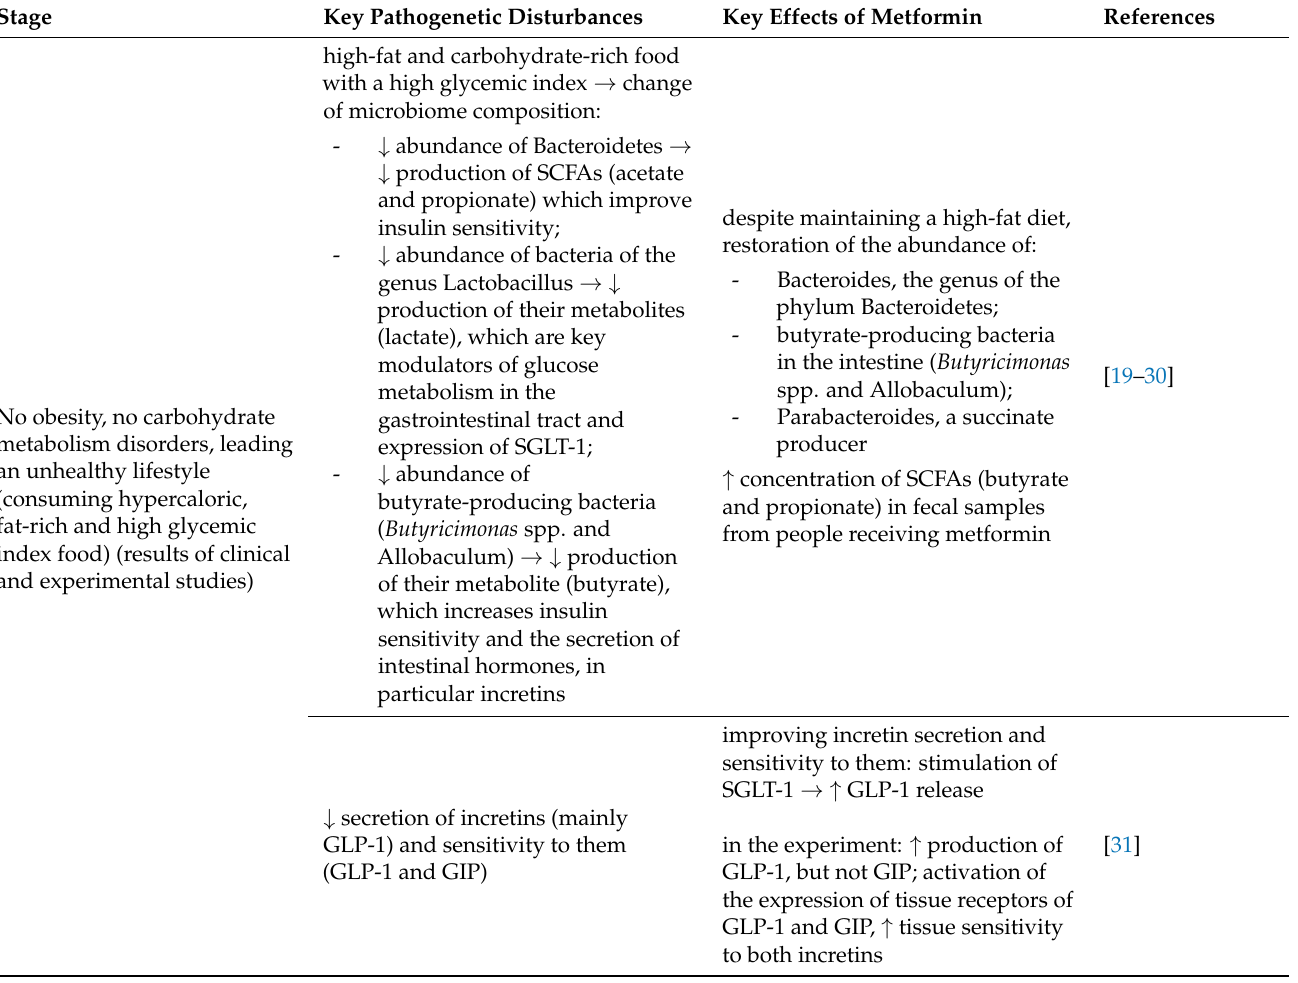
Table 1. Key effects of metformin at different stages of disorders of carbohydrate